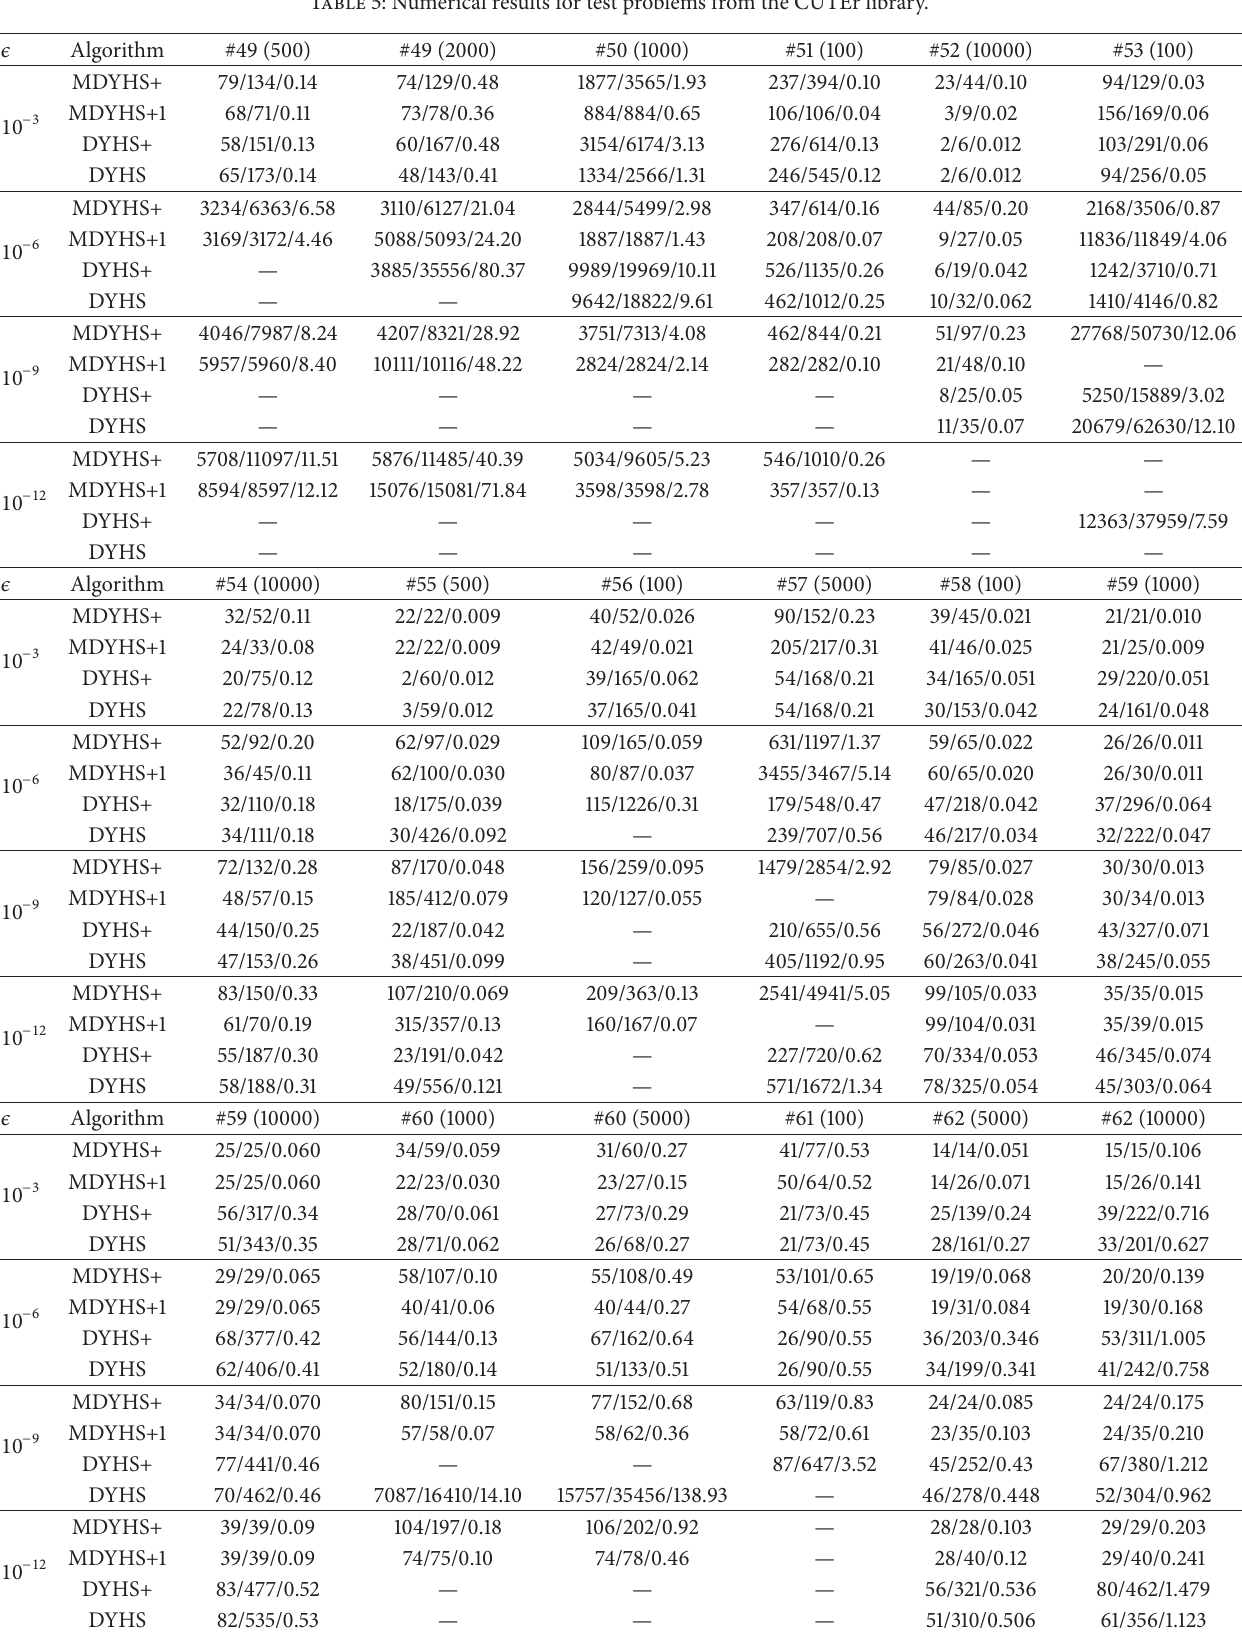
Table 5: Numerical results for test problems from the CUTEr